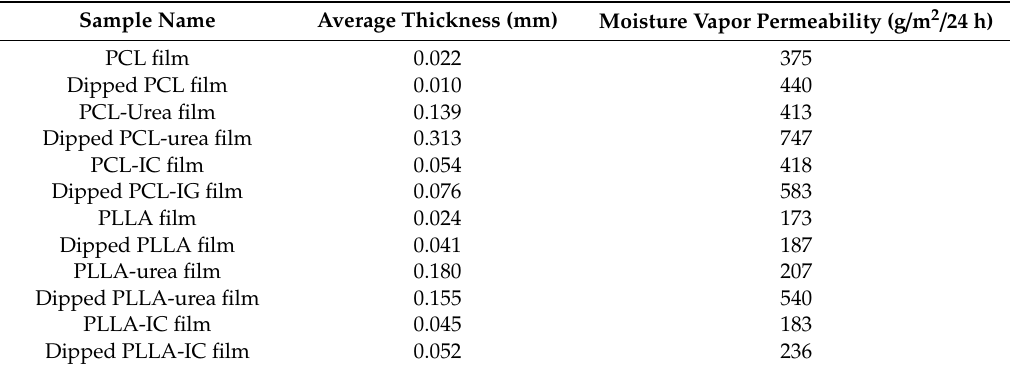
Table 3. Thicknesses and moisture vapor permeabilities of neat and U- or PCL-U-IC embedded PCL and PLLA films before and after soaking in methanol obtained with permission from [47]. Copyright 2001